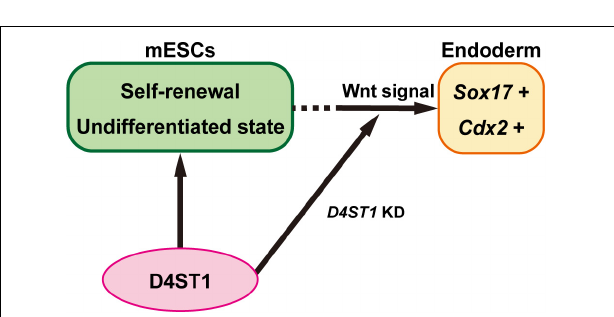
FIGURE 3 | Wnt signaling is activated by D4ST1 KD. (A,B) Western blotting analysis of p-Smad1/5/8 and Active- β -catenin in D4ST1 KD mESCs at TF day 4. Histogram shows the mean densitometric readings of bands normalized to β -actin, and was shown relative to the control (set to 1). The representative bands of the loading control ( β -actin) are the same as those in Figure 1C because the same samples were used for these analyses. (C) Western blotting analysis of Active- β -catenin in D4ST1 O/E mESCs at TF day 2. Histogram shows the mean densitometric readings of bands, which were normalized to β -catenin and are shown relative to the control (set to 1). The values shown are means ± SD ( N = 3). Those significantly different to the